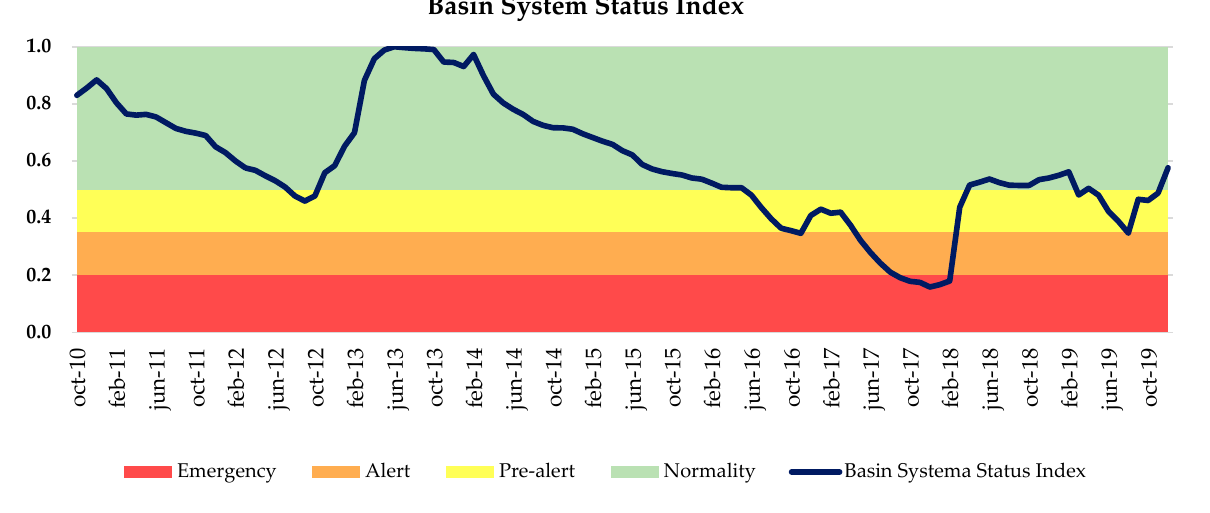
Figure 6. Evolution of the Basin System Status Index, period October 2010-December 2019. Source: own elaboration based on [62].